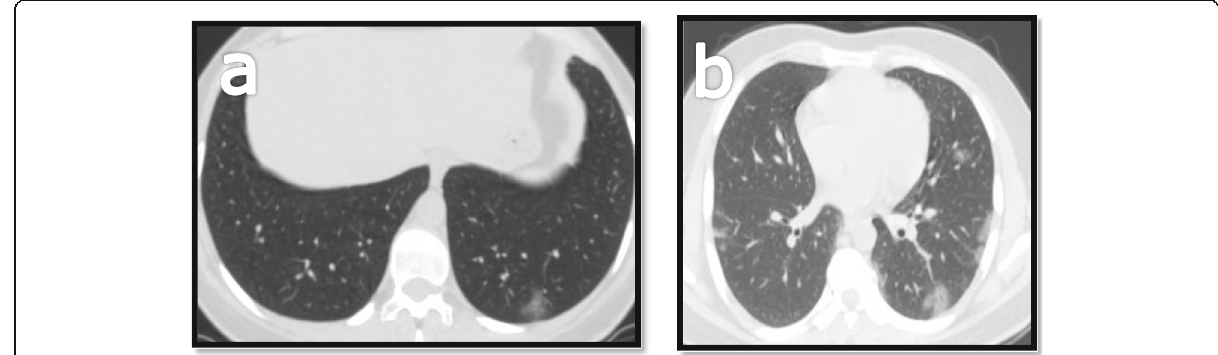
Fig. 5 a MDCT scan for a 28-year-old male patient showing left lower lung lobe basal subpleural simple GGO. b MDCT scan for a 39-year-old male patient showing bilateral mainly peripheral subpleural GGO more predominant at the left lower lung